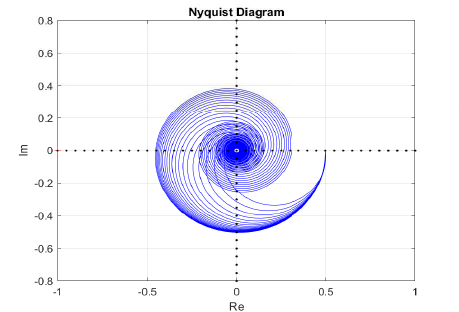
Figure 3. Nyquist diagrams of the original system for ω